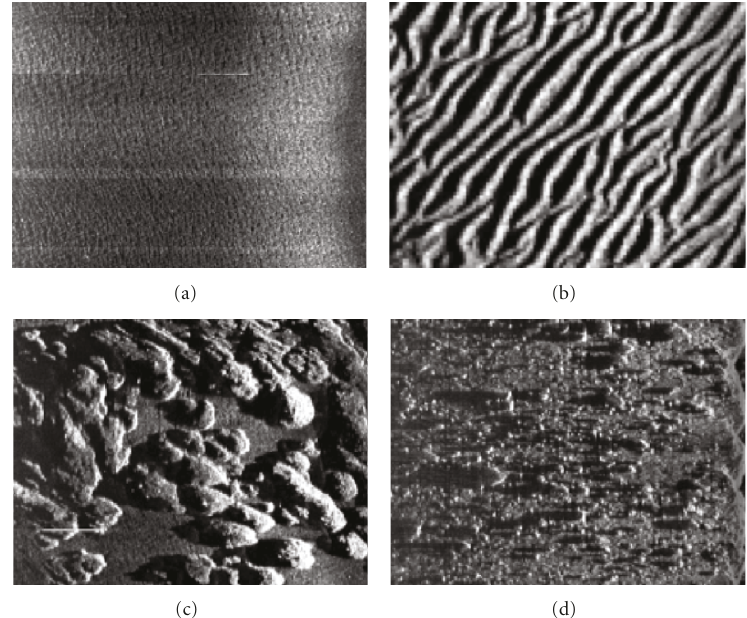
Figure 2: Snapshots of four di ff erent types of seabed: (a) flat seabed, (b) sand ripples, (c) rocky seabed and (d) cluttered environment. operator visualisation or intervention. For this reason the use of collaborating multiple platforms requires robust and accurate on-board decision